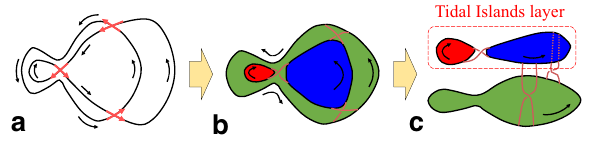
Fig. 4 Tidal islands from the Seifert surface of the dual nodal knot metal (NKM). a The previously discussed dual Trefoil NKM with a reversed nodal line (NL), such that each crossing has a reversed director u ( k ). b The dual Seifert surface is constructed by promoting each crossing into a twist that connects regions bounded by the dual NL. c Resultant Seifert surface with a layer of islands isomorphic to the original tidal islands of